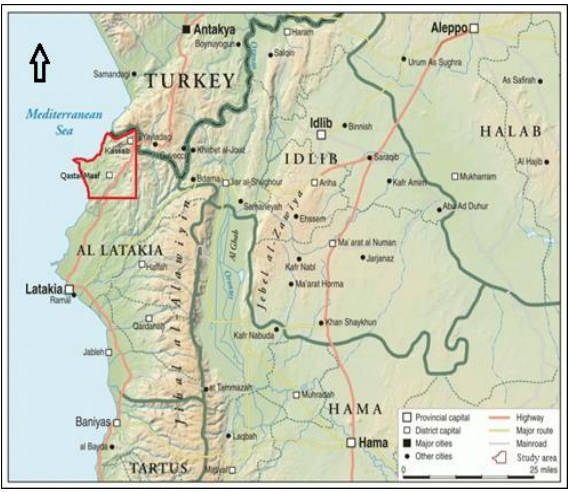
Figure 1. The location of the study area and the main roads.